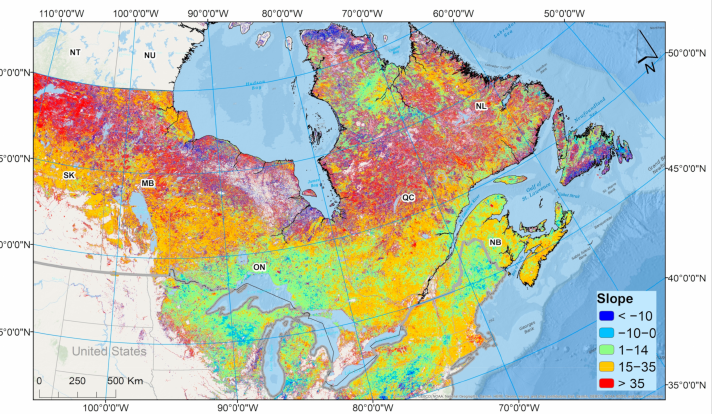
Figure 7. Changes in annual cumulative surface degree days >0 ◦ C of forest covered areas in Central and Eastern Canada from 2000 to 2015.